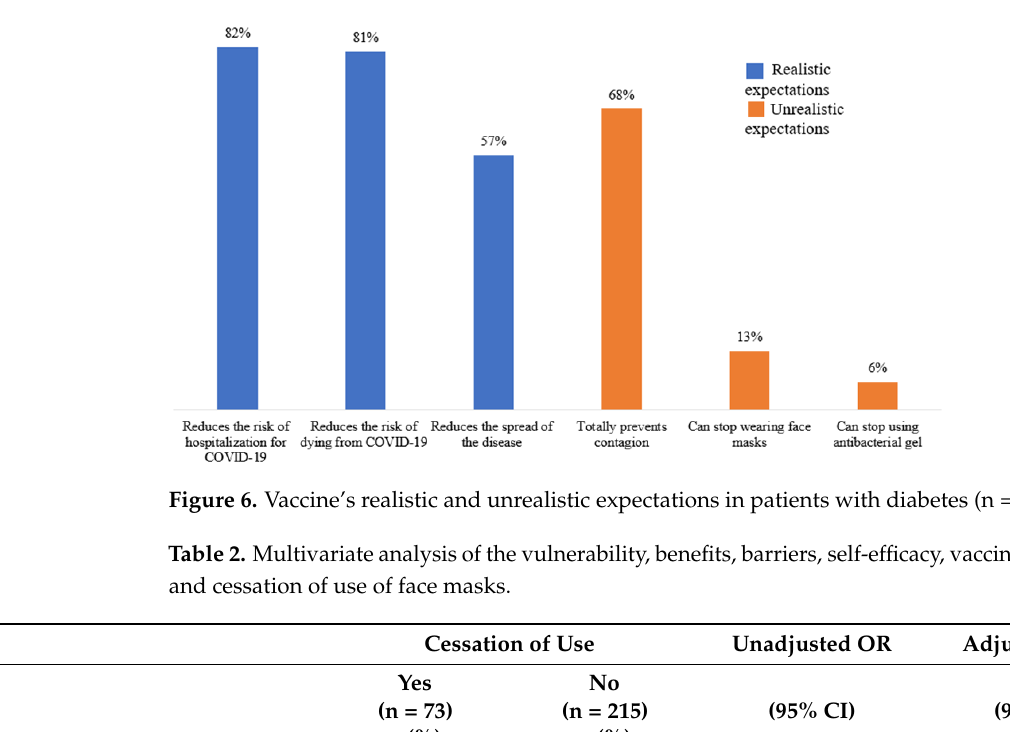
Figure 5. Self-efficacy (high or very high) of wearing face masks in patients with diabetes (n = 288).